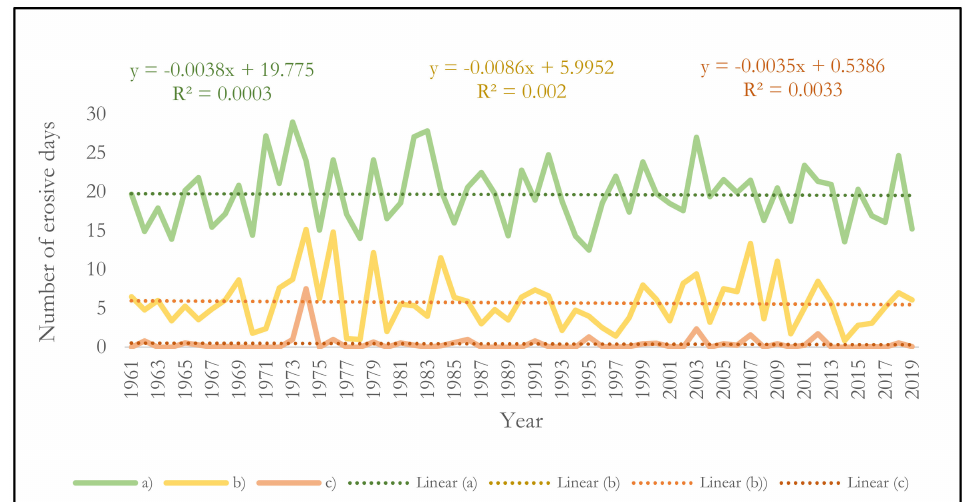
Figure 7. Yearly Duer occurrence for scenarios a, b, and c.